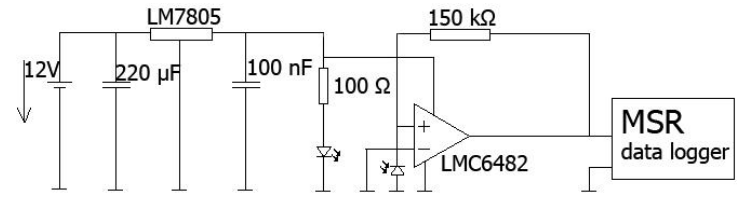
Figure 3. Sketch illustrating the electronics used to power the LED, and to amplify and to log the signal from the